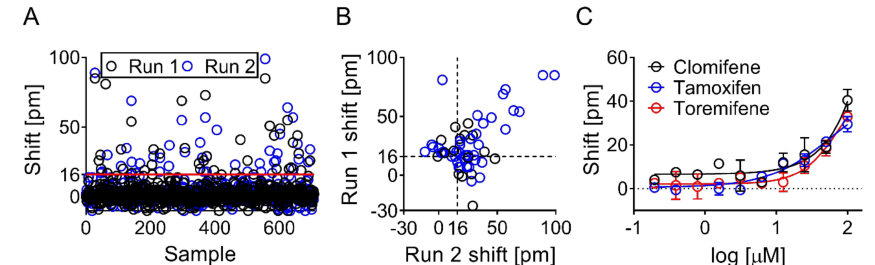
Figure 5. Screening and hit identification on the Corning Epic. ( A ) Hit threshold was set to five times the median absolute deviation (MAD), and a shift above 16 pm was considered a hit. In total, 59 compounds met the criteria to be considered a hit. ( B ) The correlated shifts from both runs are shown. Forty-five of these hits indicated as blue circles were prioritized and tested in 10-point concentration response assays on the Corning Epic, with a top concentration of 100 µ M, and 14 compounds showed a concentration-dependent effect, examples of which are shown in panel ( C ). Remaining binding curves are found in Supplementary Figure S4.